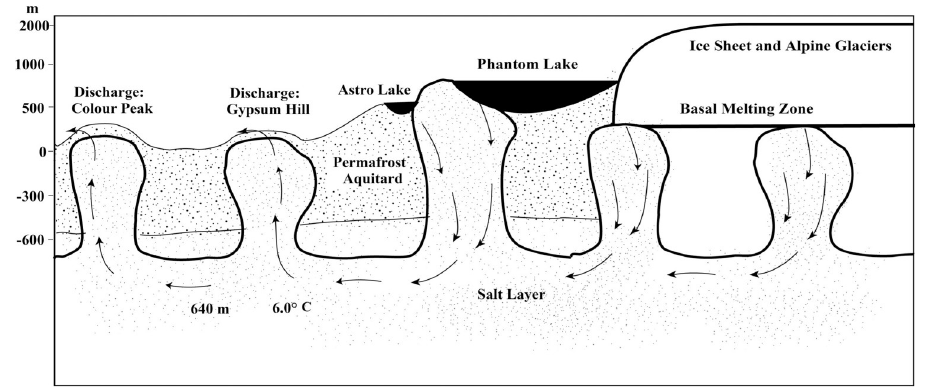
Fig 2. Schematic diagram depicting the sources of gas and water showing the contribution of lakes and subglacial melt and the flow of subsurface water through the salt strata associated with the diapirs. Modified from Andersen et al. [7].